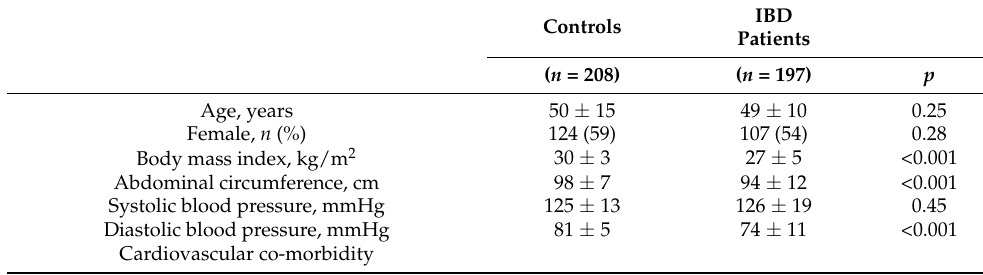
Table 1. Characteristics of patients with inflammatory bowel disease and